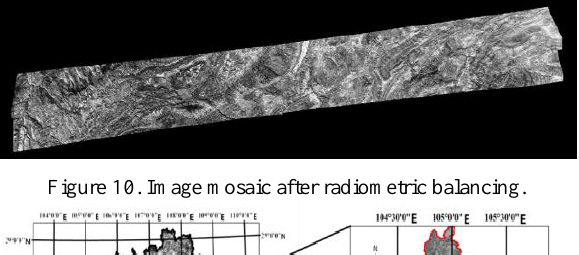
Figure 10. Image mosaic after radiometric balancing.